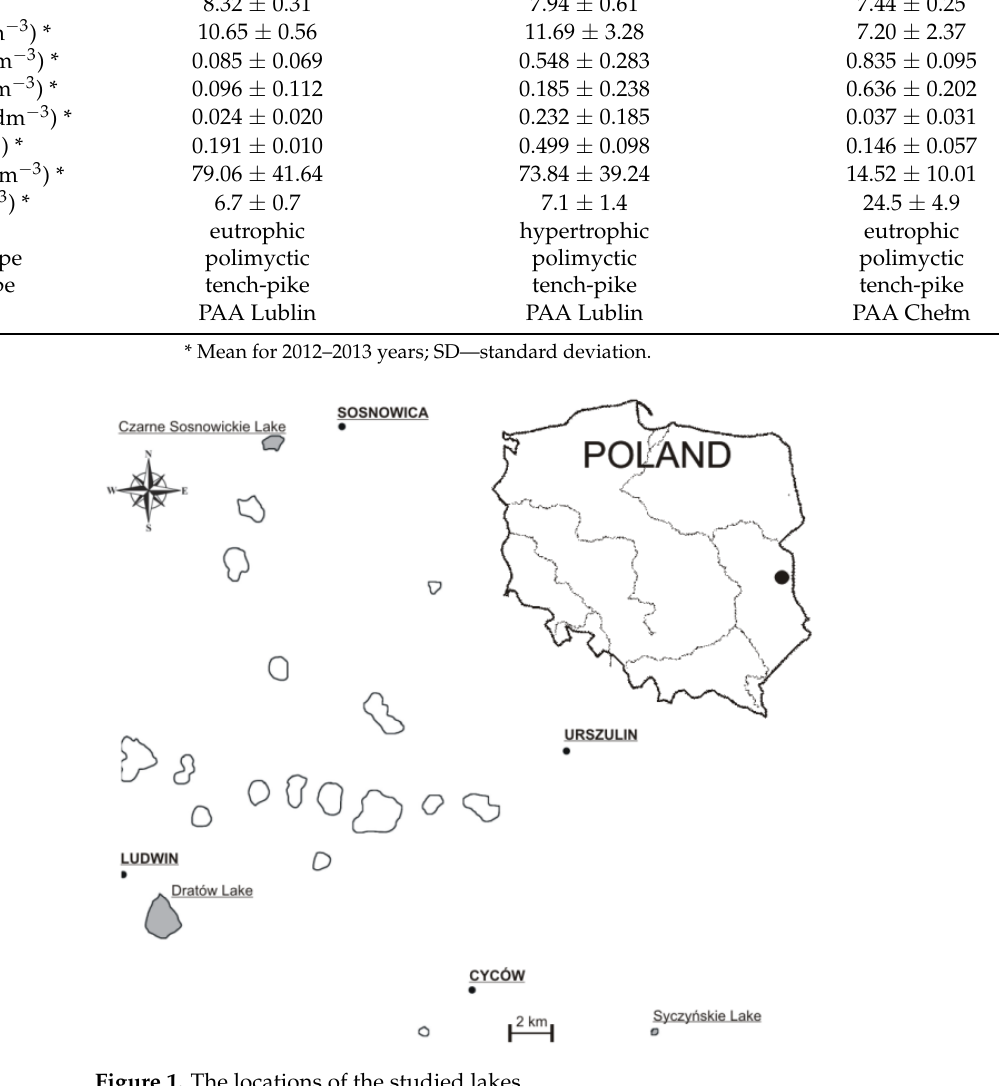
Figure 1. The locations of the studied lakes.